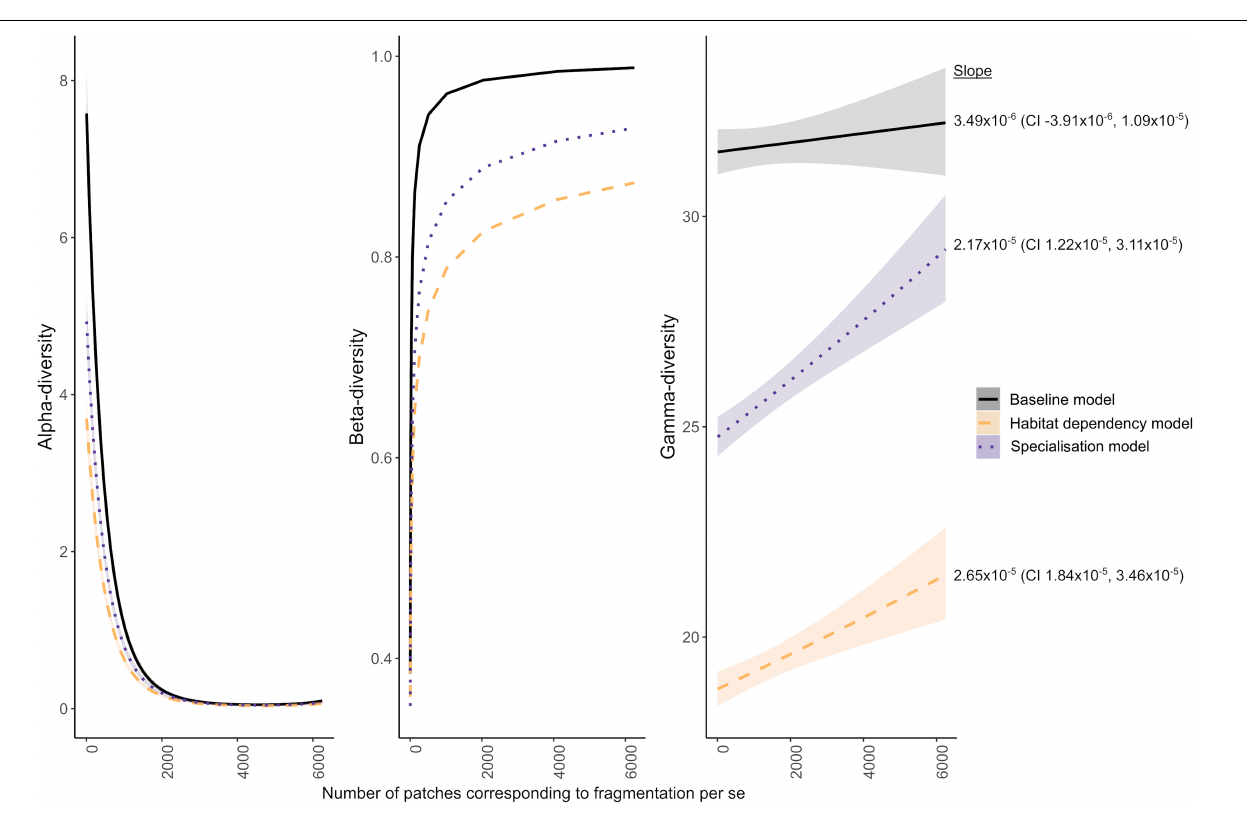
FIGURE 4 | Mean patch scale alpha-diversity, mean pairwise beta-diversity and gamma-diversity for all species in the focal-habitat at 10% cover, with fitted lines and standard errors. Gamma-diversity increased with the number of patches (albeit not greatly for the baseline model), which represents FPS. In all cases, alpha-diversity declined, and beta-diversity